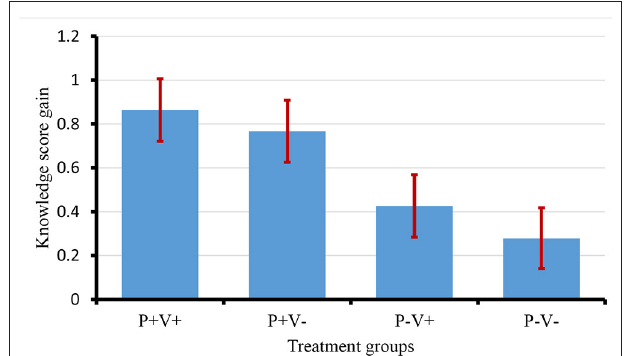
FIGURE 4 | Adjusted knowledge change scores by group (standard error bars